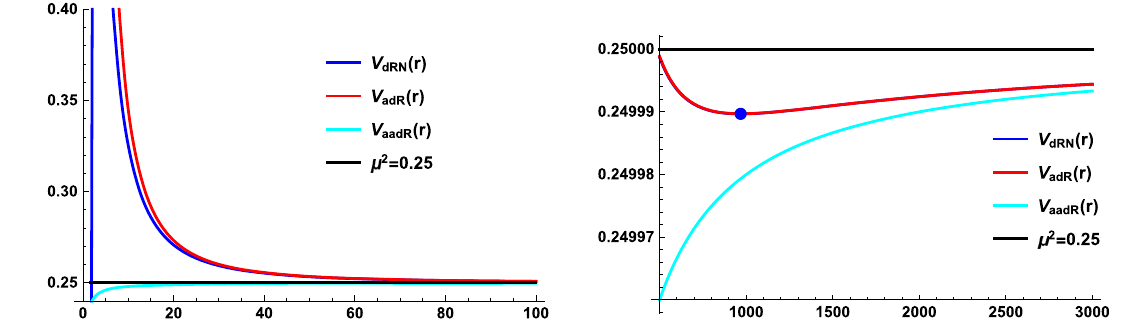
Fig. 3 (Left)Potential V dRN ( r ) as function of r ∈ [ r + = 1 . 62 , 100 ] with M = 1 , Q e = 0 . 6 , Q m = 0 . 5 ,ω = 0 . 2 , q = 2 , l = 3 ,μ = 0 .